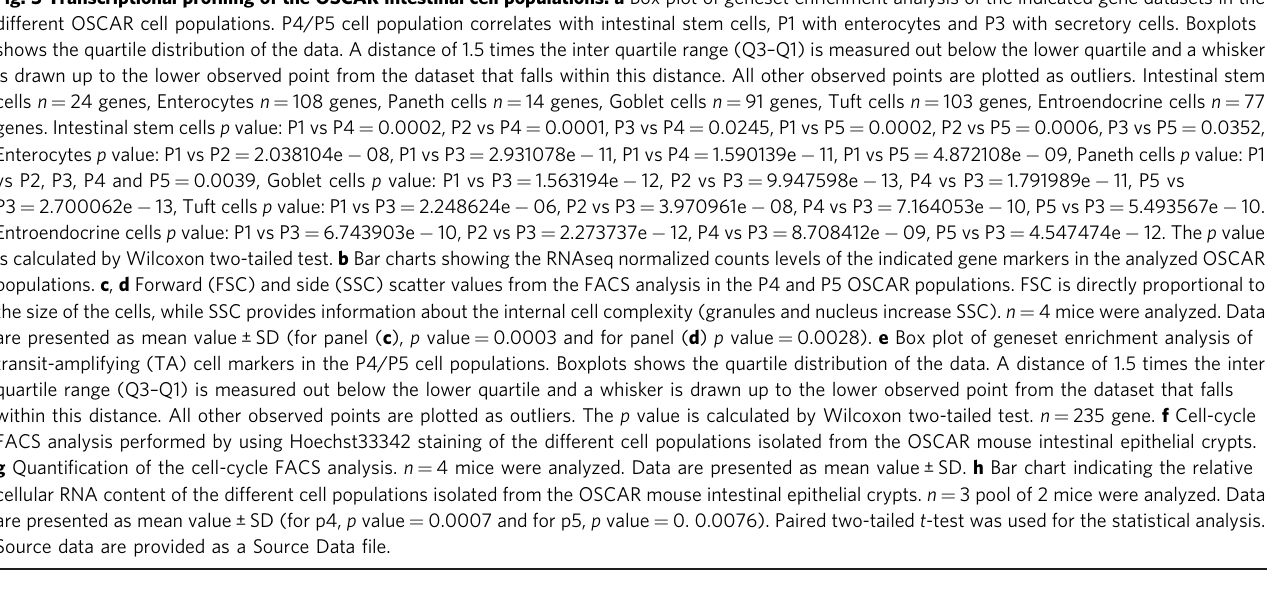
(Thermo Fisher Scienti fi c) were used at 1:500 dilution before mounting (DEPEX, VWR): Alexa Fluor 488 donkey anti-mouse IgG (H + L), (A21202), Alexa Fluor 568 donkey anti-mouse IgG (H + L) (A10037), Alexa Fluor 647 donkey anti-mouse IgG (H + L) (A31571), Alexa Fluor 488 donkey anti-rabbit IgG (H + L) (A21206), Alexa Fluor 568 donkey anti-rabbit IgG (H + L) (A10042), Alexa Fluor 647 donkey anti-rabbit IgG (H + L) (A31573), Alexa Fluor 488 donkey anti-goat IgG (H + L) (A11055). Nuclei were counterstained with DAPI (Sigma). Images were taken using a Zeiss Axiovert LSM510 or Zeiss Axio Imager and images analyzed using ImageJ and Excel. Hematopoietic stem cells were isolated from mouse femur by fl ushing with cold PBS and enriched using c-Kit positive selection (1.5 μ l per 100 million cells of APC-